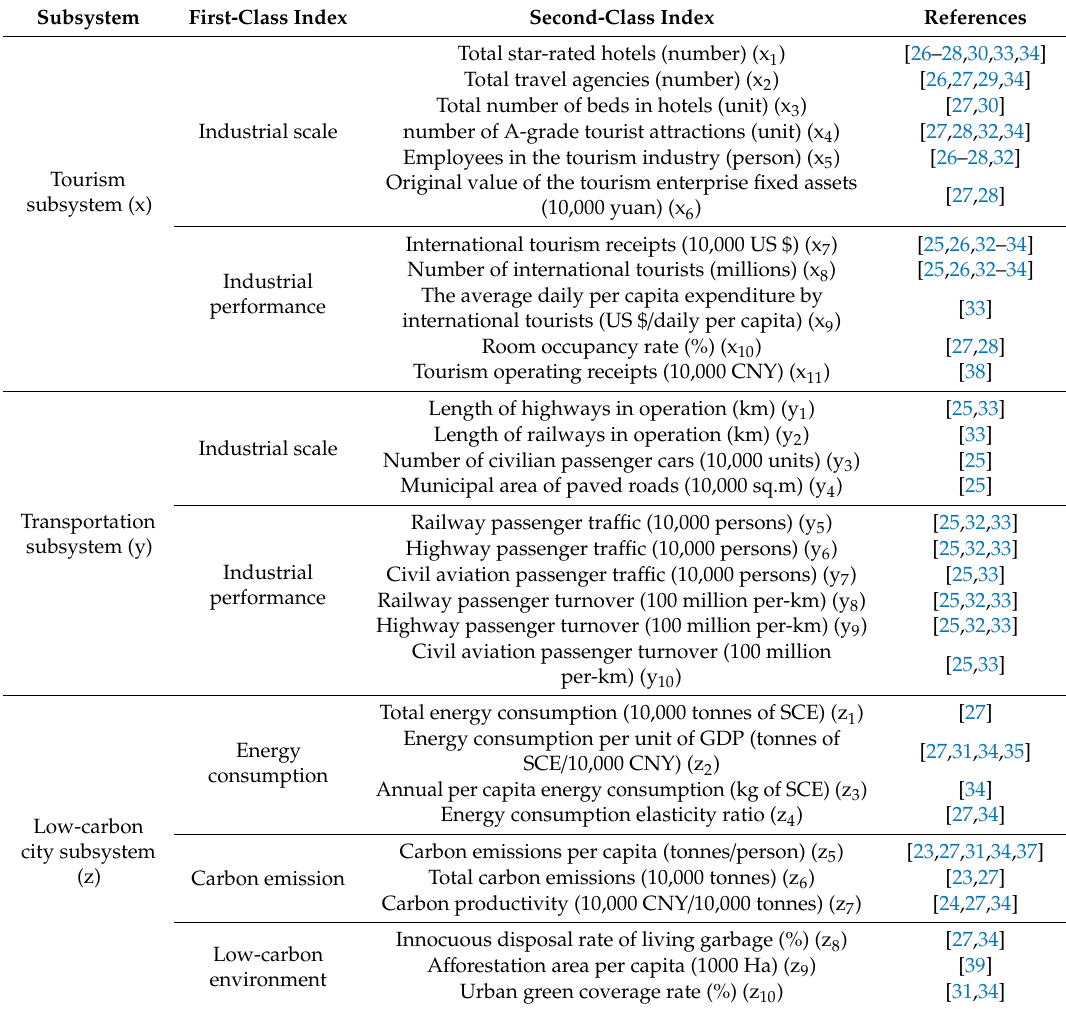
Table 1. Comprehensive evaluation index